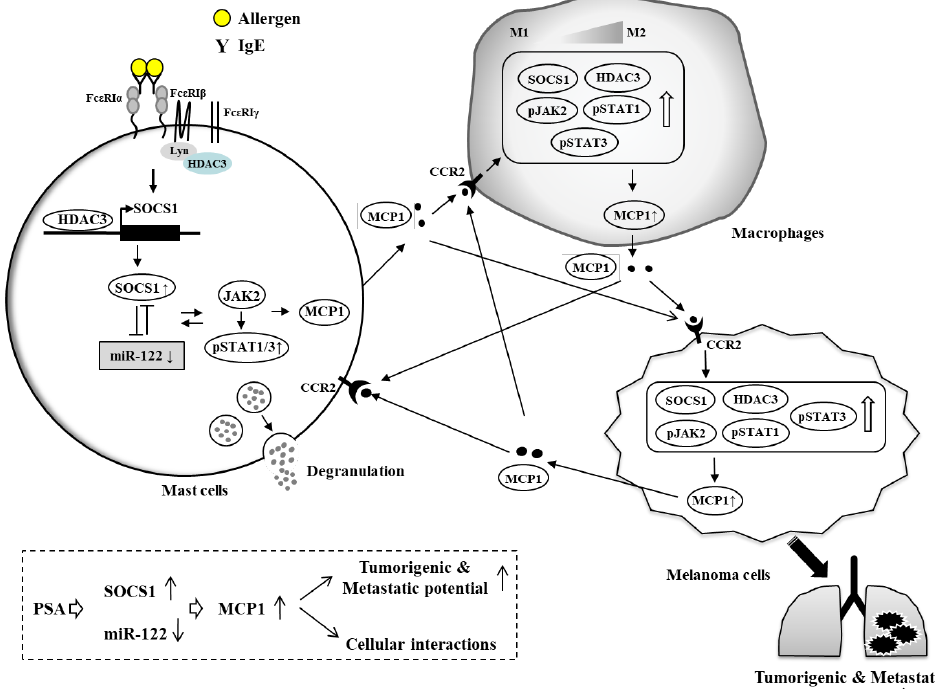
Figure 3. MCP1 mediates cellular interactions in passive cutaneous anaphylaxis (PCA) and passive systemic anaphylaxis (PSA) regulated by the miR-122-SOCS1 negative feedback loop. Allergen stimulation activates Fc ε RI signaling and increases the expression of SOCS1. HDAC3 binds to the promoter sequences of SOCS1 to increase the expression of SOCS1. Allergen stimulation decreases the expression of TGF β 1 and miR-122a-5p. In this study, TGF β 1 exerts a negative effect on allergic inflammation [7]. MiR-122a-5p and SOCS1 form a negative feedback loop. JAK2 / STA3 signaling, activated by SOCS1, is responsible for the increased production and secretion of MCP1. MCP1, through CCR2, mediates cellular interactions during anaphylaxis. MCP1 also enhances the tumorigenic and metastatic potential of melanoma cells. The → arrows denote activation of transcription and ↑ arrows denotes increased expression level / increased characteristics. Hollow arrows denote positive regulation. Both side T-bar arrows denote cross inhibition. SOCS1, Suppressor of cytokine signaling1; JAK2, Janus kinase2; MCP1, Monocyte chemoattractant protein-1; STAT, Signal transducer and activator of transcription; HDAC3, Histone deacetylase 3; CCR2, c-c chemokine receptor type 2; PSA, Passive systemic anaphylaxis.